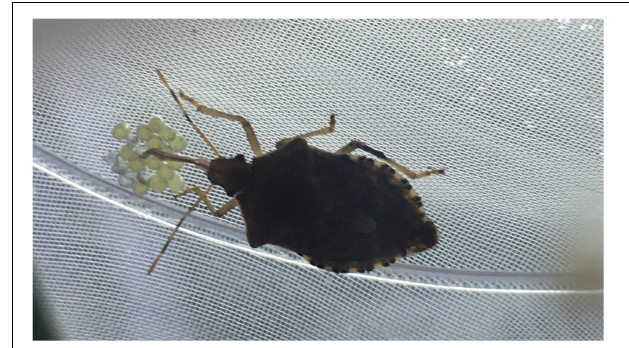
FIGURE 2 | Arma custos adult consuming eggs. After being cannibalized by the proboscis of A. custos , eggs protein were eaten and a silver-white eggshell was left